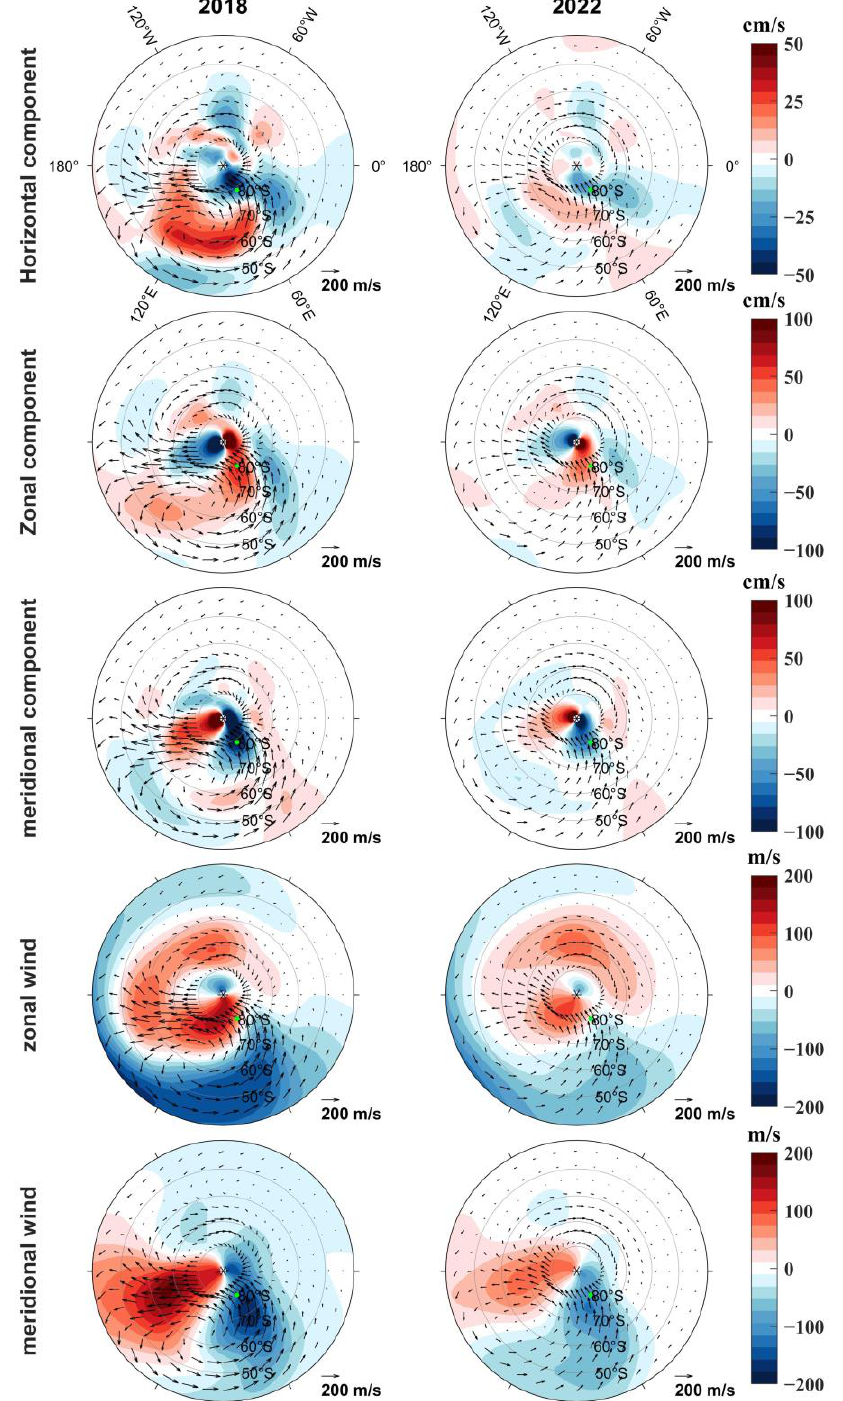
Figure 5. The left column corresponds to the 2018 storm event and the right column represents the 2022 storm event. The different rows show the effects of magnetic storms on the total horizontal divergence term (first row, same as the third row in Figure 4), the zonal component of the horizontal divergence term (second row), the meridional component of the horizontal divergence term (third row), the zonal wind (fourth row), and the meridional wind at 14:20 UT around 130 km. The green dot is located at (78.75 ◦ S, 60 ◦ E), which is the location where the kinetic diagnostic analysis is performed. The arrows show the magnitude and direction of the horizontal wind. The black asterisks mark the locations of the South